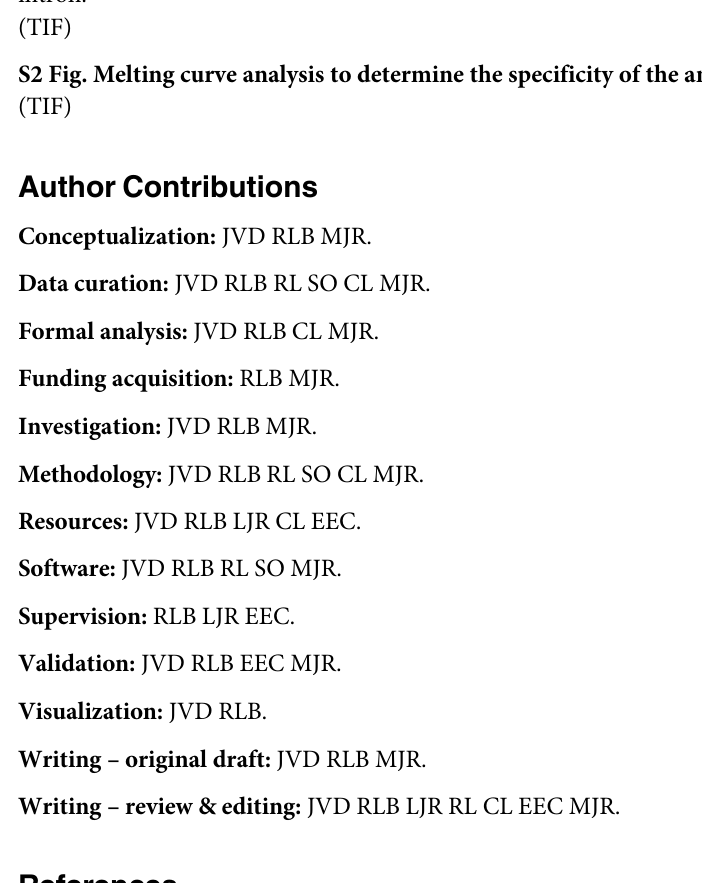
S1 Fig. Position of reference genes exons and primer pairs. X-axis represent fragment length in bp. Bottom row on X-axis shows number and position of exons. On top of exons, primer sequences forward and reverse are shown. Red color denotates forward primer spanning an intron. S2 Fig. Melting curve analysis to determine the specificity of the